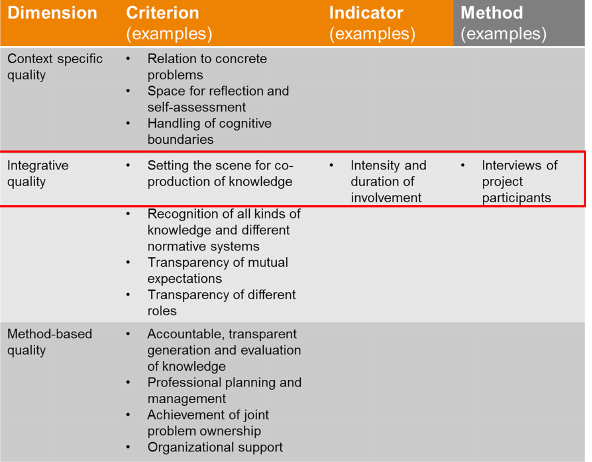
Figure 4. The example demonstrates how one criterion out of the dimension “integrative quality” within the research and develop- ment process might be assessed. It only shows a selection of pos- sible criteria. The interviews might use the Likert scale (1–5) to quantify the result in some way.